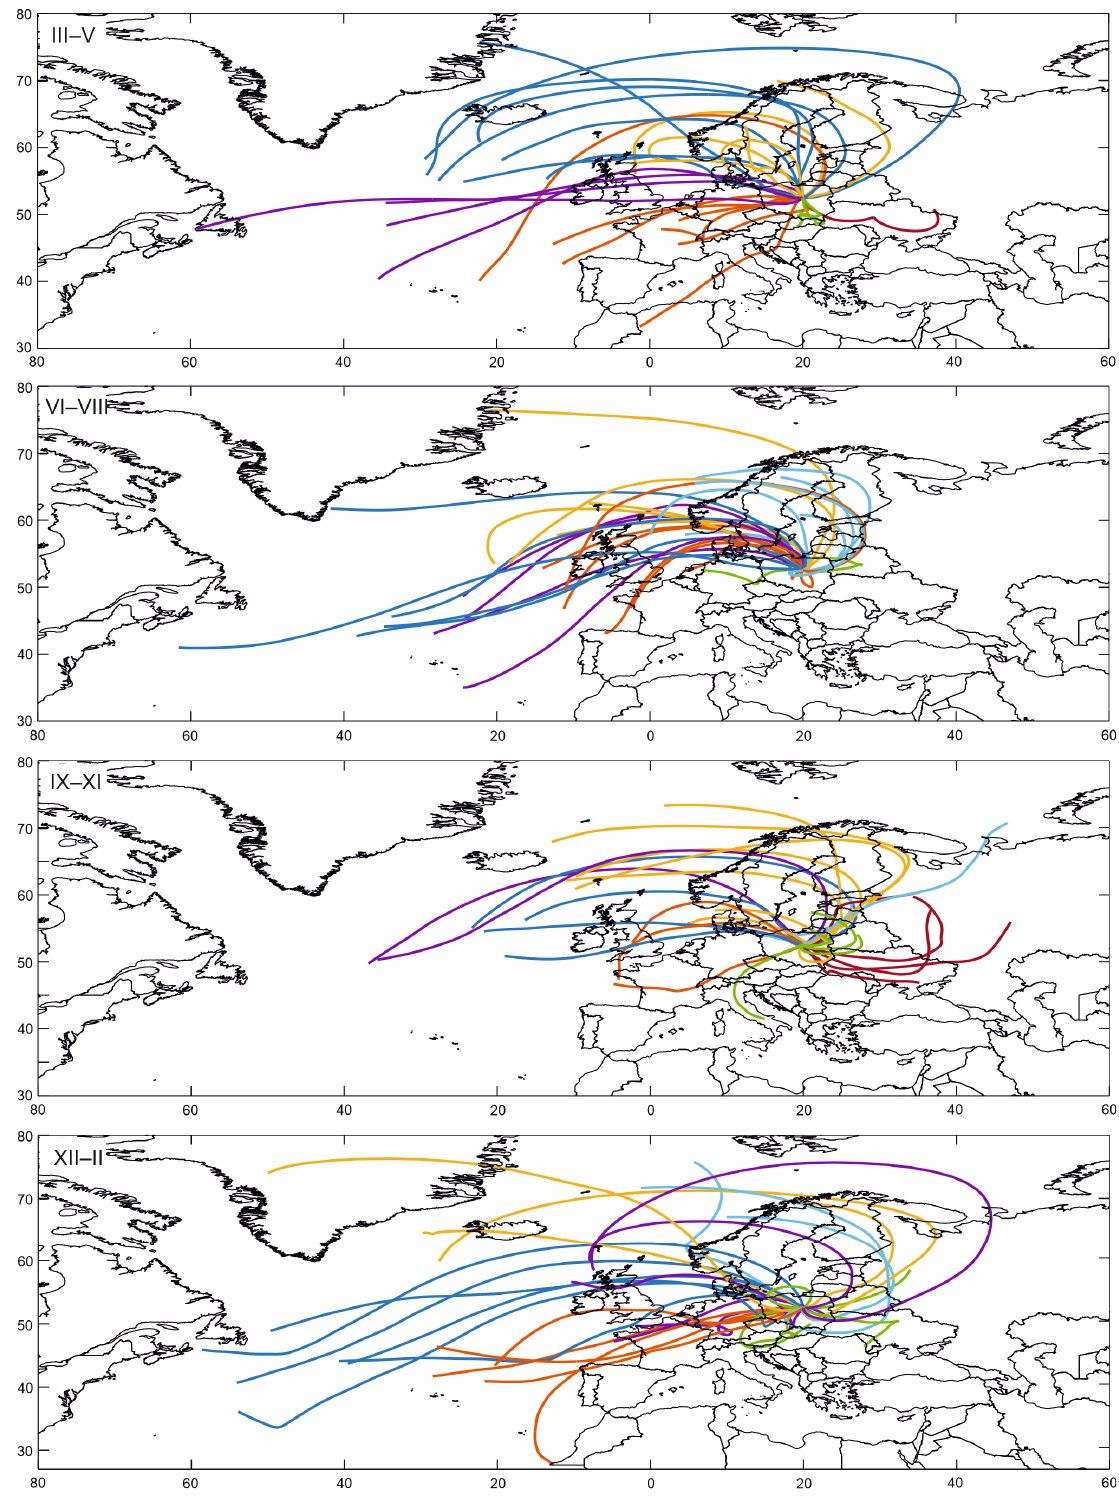
Figure 5. 72 ‐ h backward trajectories ending at the grid point 52.5° N, 20° E at 12:00 UTC at 3000 m above ground level on days with the largest sums of global solar radiation (above the 0.99 percentile) over Poland, broken down by seasons of the year in the period 1986–2015. The colours of the trajectories correspond to the colours of the clusters in Figure 4.